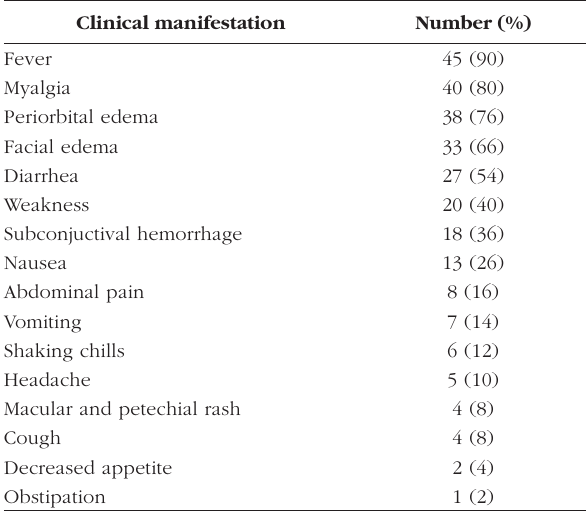
Table I. – Clinical manifestations in a series of 50 patients hospitalized for trichinellosis.